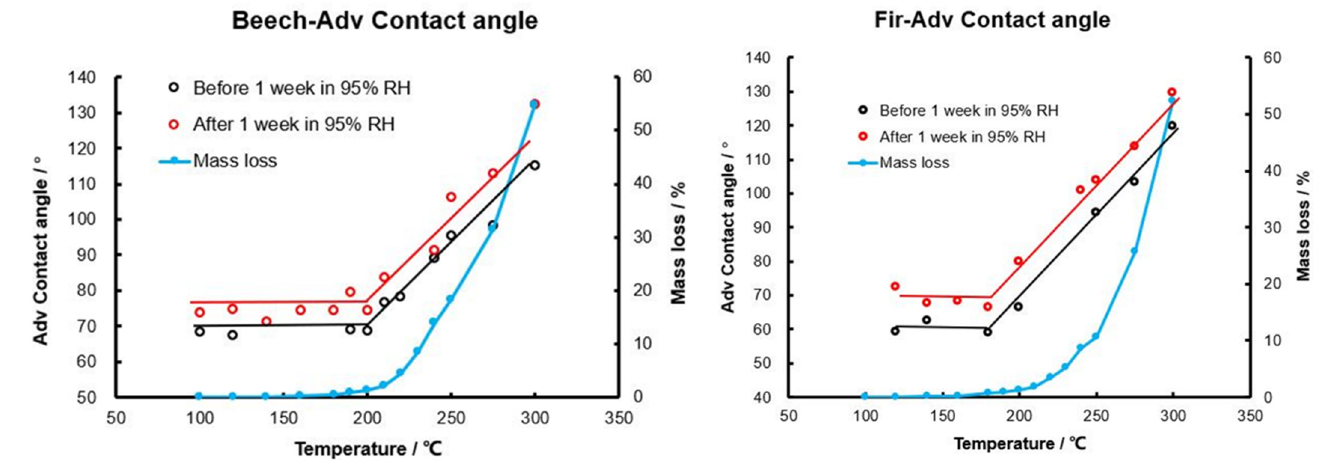
Figure 12. The advancing contact angles of beech ( left ) and fir ( right ) heat-treated at different heat treating temperatures after the humid test by being placed in a 95% relative humidity environment for 1 week.